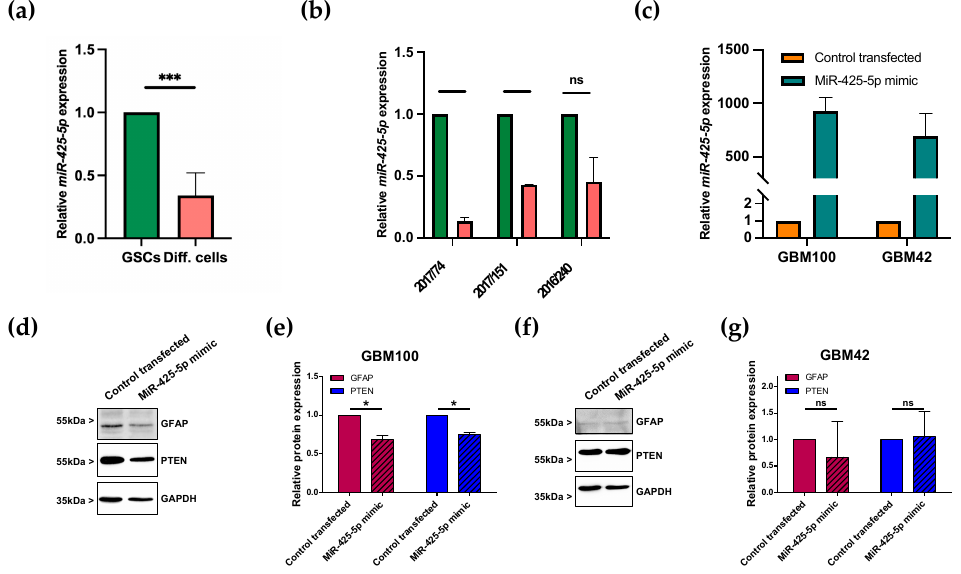
Figure 3. Expression of miR-425-5p in GSCs and effects on GFAP and PTEN protein levels in GBM cells. ( a ) Expression of miR-425-5p in GSCs (green) and their differentiated state (red). RT-qPCR results for differentiated 2017/74, 2017/151, and 2016/240 were normalized to undifferentiated controls. ( b ) Detailed depiction of miR-425-5p expression in each GSC line (green) and its corresponding differentiated state (red). Results are shown as mean values ± SD of two independent experiments. ( c ) miR-425-5p mimic transfection of primary GBM cell lines GBM100 and GBM42. ( d ) Representative Western blot demonstrating GFAP and PTEN expression after miR-425-5p mimic transfection in GBM100 cells. ( e ) Quantification of GFAP and PTEN protein expression in transfected GBM100 cells. ( f ) Representative Western blot demonstrating GFAP and PTEN expression after miR-425-5p mimic transfection in GBM42 cells. ( g ) Quantification of GFAP and PTEN protein expression in transfected GBM42 cells. Two independent experiments were conducted. Results are presented as mean values ± SD. A paired Student’s t -test was applied to determine significance: ns p > 0.05, * p < 0.05, *** p < 0.001.